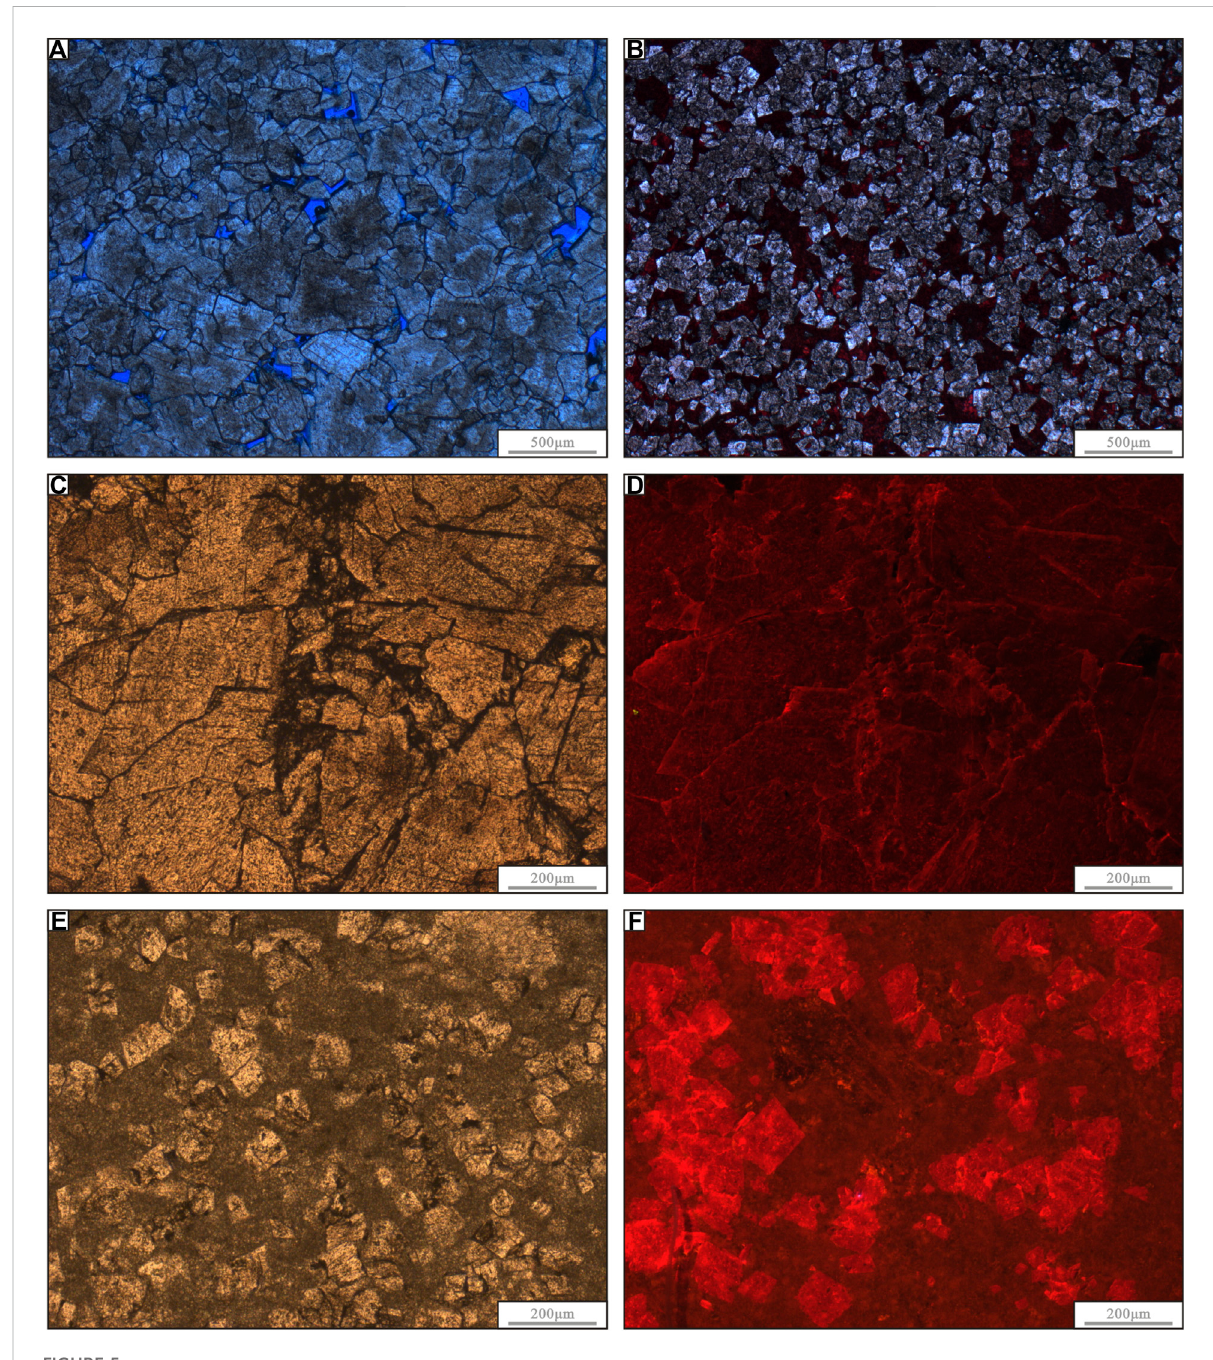
FIGURE 5 Petrological characteristics of Rd4. (A) . Plane-polarized-light image of an Rd4 sample with medium-coarse crystalline size showing anhedral texture, some dolomite with misty centers and clear rims, and un fi lled pores. The sample was obtained from well QK-1 in the Buqu Formation at a depth of 308.97 m. (B) . Plane-polarized-light image of an Rd4 sample showing incomplete dolomitization, and the accumulation of a fi ne dolomite crystal mosaic. The sample was obtained from well QZ12 in the Buqu Formation at a depth of 105.02 m. (C) . Plane-polarized-light image of an Rd4 sample with coarse crystalline size showing planar subhedral textures and asphalt- fi lled microcracks. The sample was obtained from well QZ12 in the Buqu Formation at a depth of 54.86 m. (D) . Cathodoluminescence image of the Rd4 sample in (C) . These crystals show a very dull red, which is brighter in a few dolomite areas along the crystalline edge. (E) . Plane-polarized-light image of an Rd4 sample showing fi ne crystal dolomite with incomplete dolomitization. The sample was obtained from well QZ12 in the Buqu Formation at a depth of 66.26 m. (F) . Cathodoluminescence image of the Rd4 sample in (E) . These crystals show a dull red, while the calcite does not emit